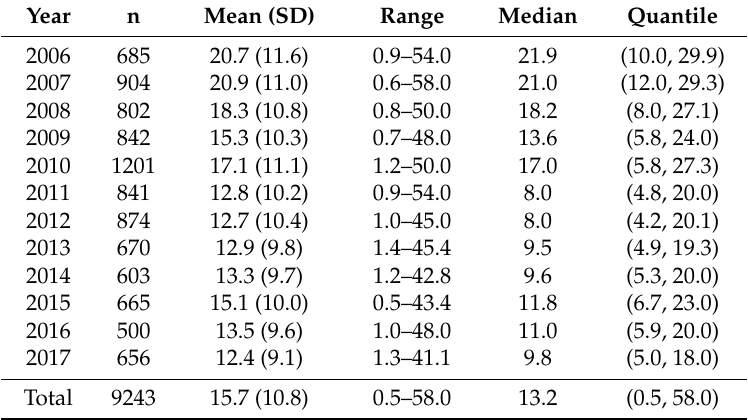
Table 4. The changing trend of the average exposure duration of pneumoconiosis cases from 2006 to